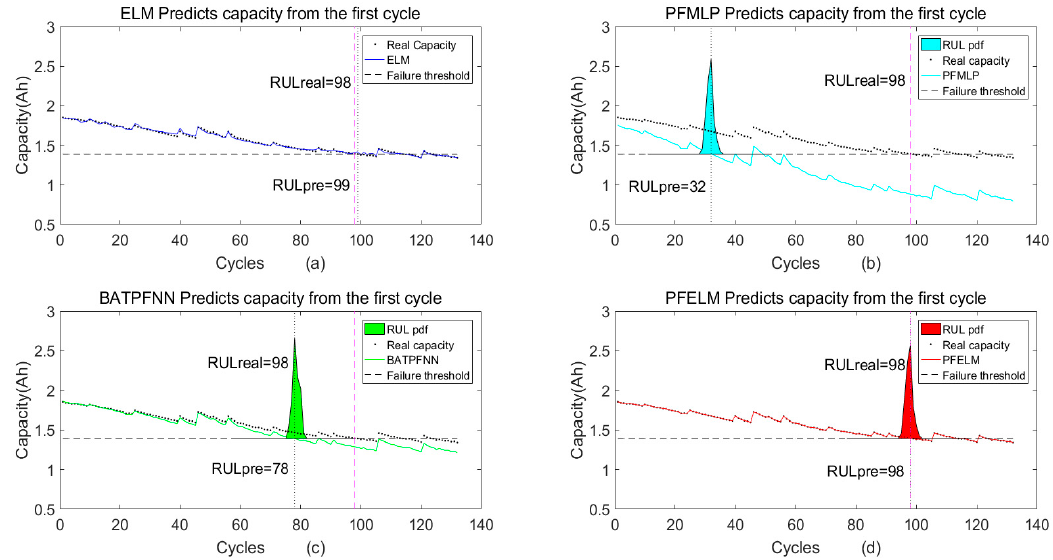
Figure 22. Predicting capacity from the first cycle by different algorithms: ( a ) ELM ; ( b ) PFMLP; ( c ) BATPFNN; ( d ) PFELM.